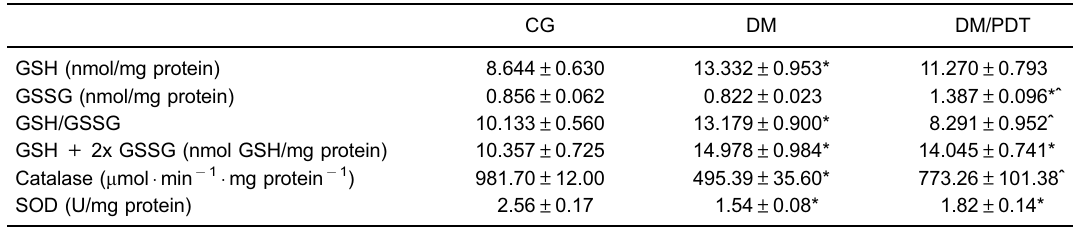
Table 3. Activity of the antioxidant system on total liver homogenates of Wistar rats after 14 days of oral administration of chlorophyll-based extract (CBE; 22 mg/L).